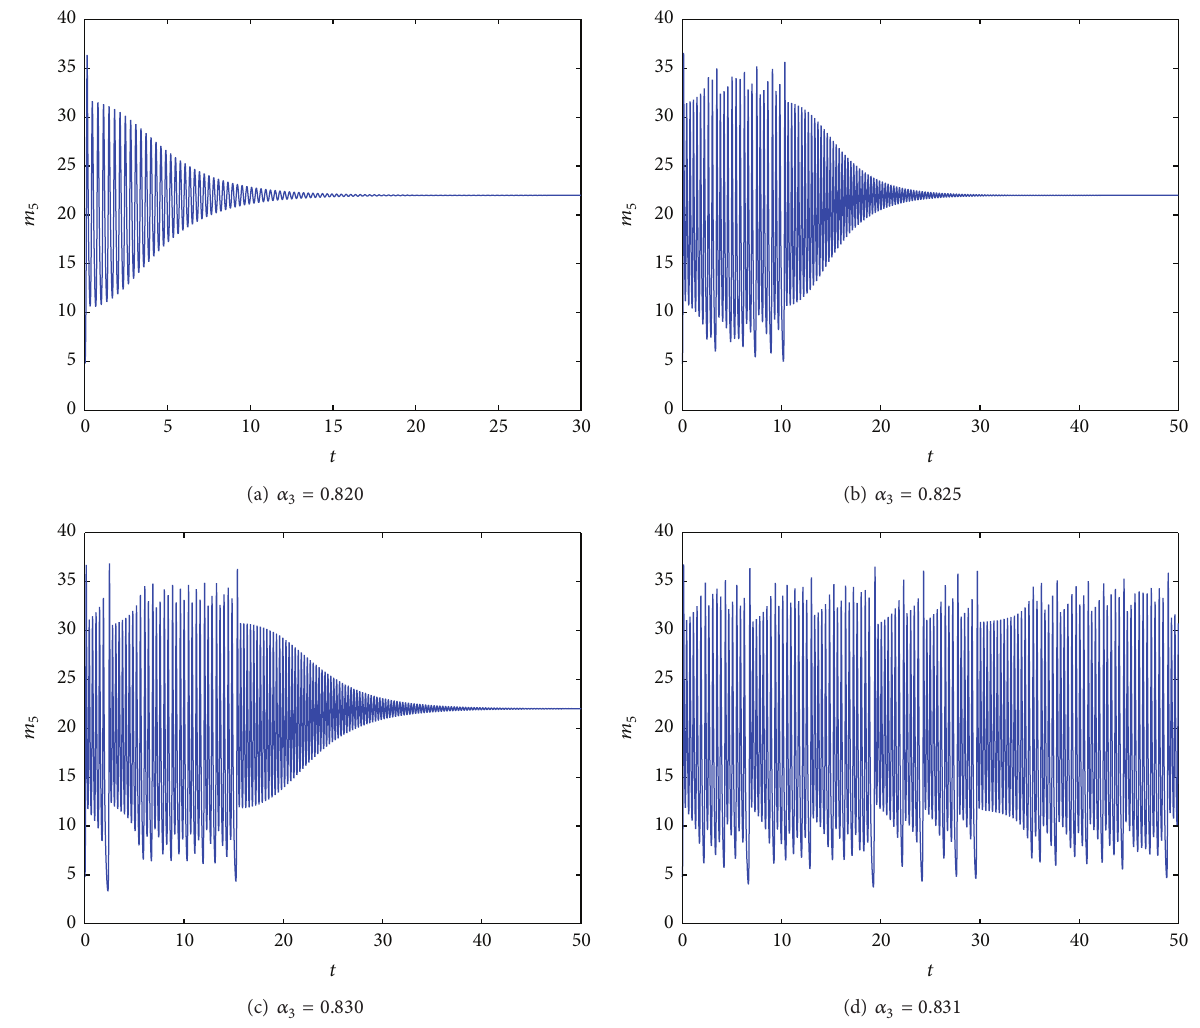
Figure 10: Time histories showing the rout to chaos via intermittency for system (5) at 𝛼 1 = 𝛼 2 = 1 with 𝛼 3 varying.